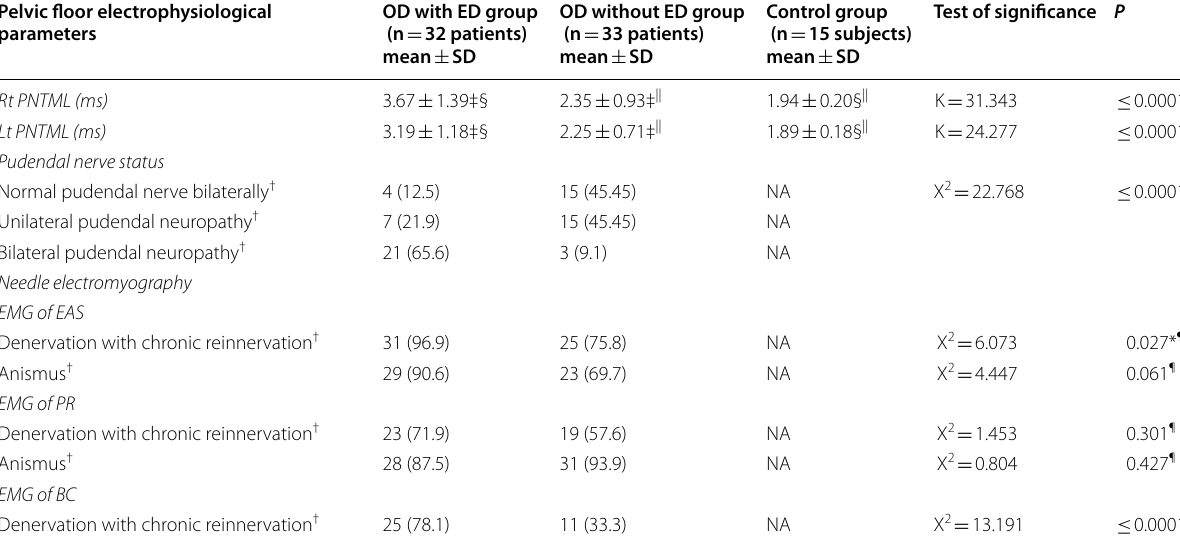
Rt, right side; PNTML, pudendal nerve terminal motor latency; Lt, left side; ms; millisecond; EMG, electromyography; EAS, external anal sphincter muscle; PR, puborectalis muscle; BC, bulbocavernosus muscle; OD, obstructed defecation; ER, erectile dysfunction; n, number of subjects; SD, standard deviation; NA, not applicable; K, value of Kruskel-Wallis test; X 2 , value of Chi-square test